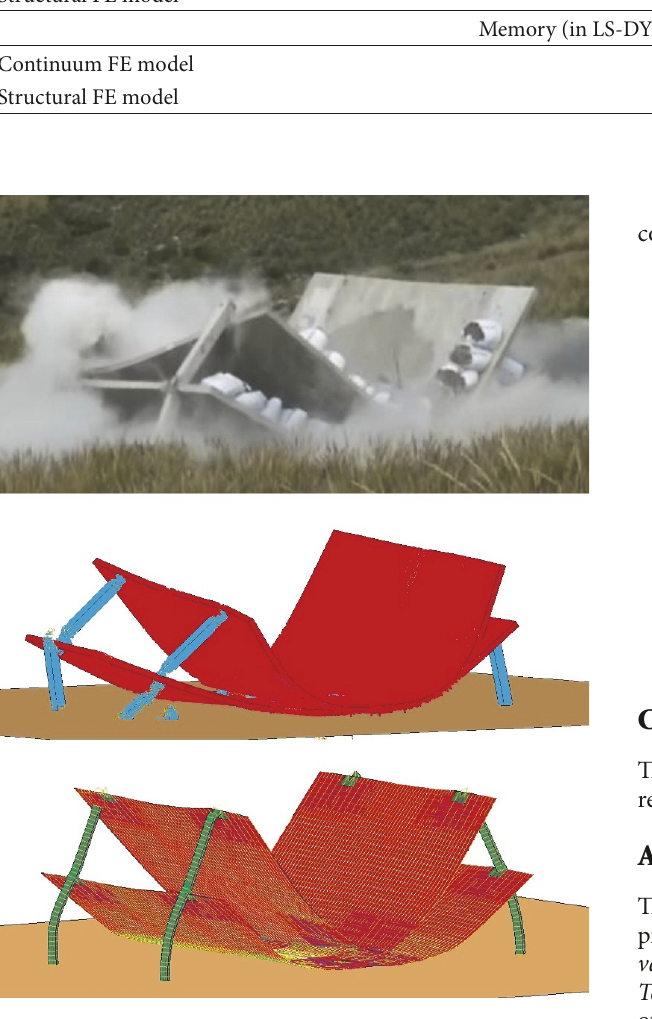
Figure 12: Comparison between test, continuum model, and struc- tural model at 2.6 s after column